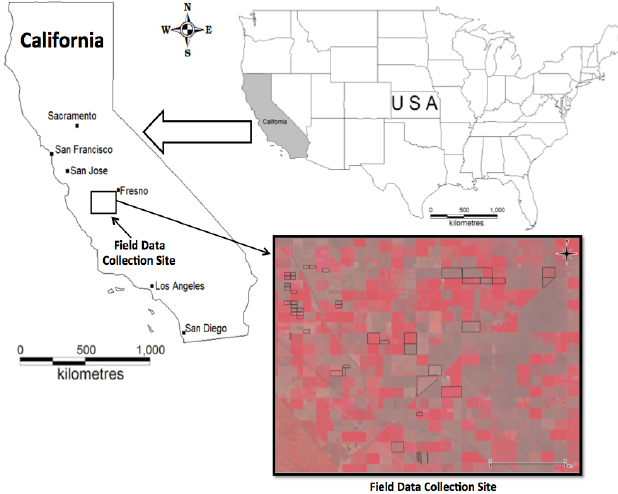
Figure 1. Study area: San Joaquin Valley in central California. Field data collection site in San Joaquin Valley with surveyed boundaries (marked in black color polygons) overlaid on a false color composite (FCC) of Landsat data from which ground fractional cover were derived for validation.